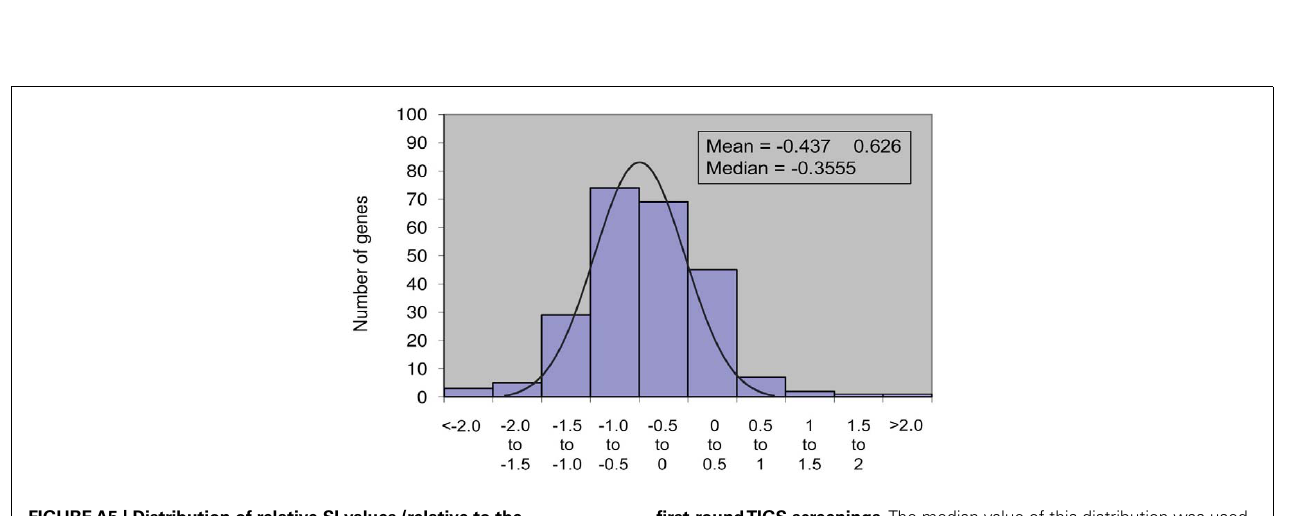
FIGUREA5 | Distribution of relative SI values (relative to the empty-vector control pIPKTA30) of 1084 RNAi constructs obtained in